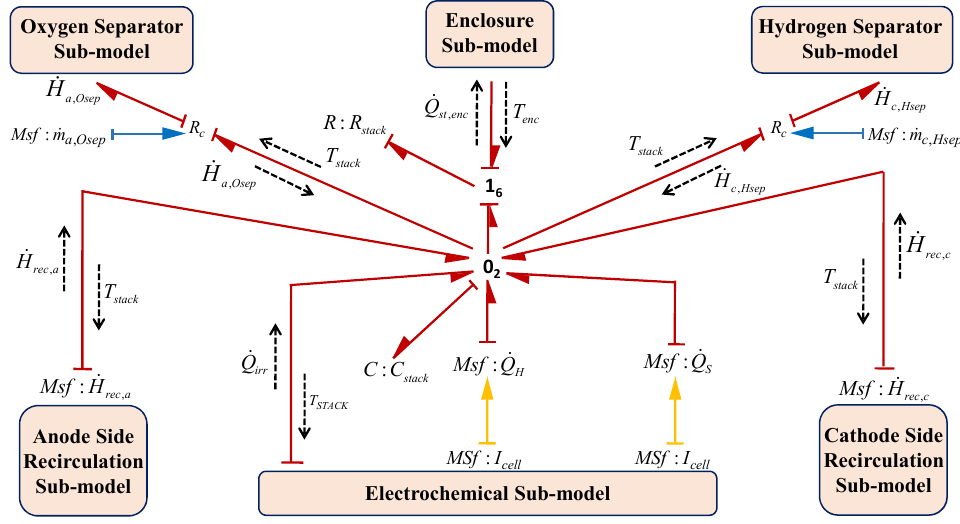
Figure 11. The BG thermal sub-model in capsule